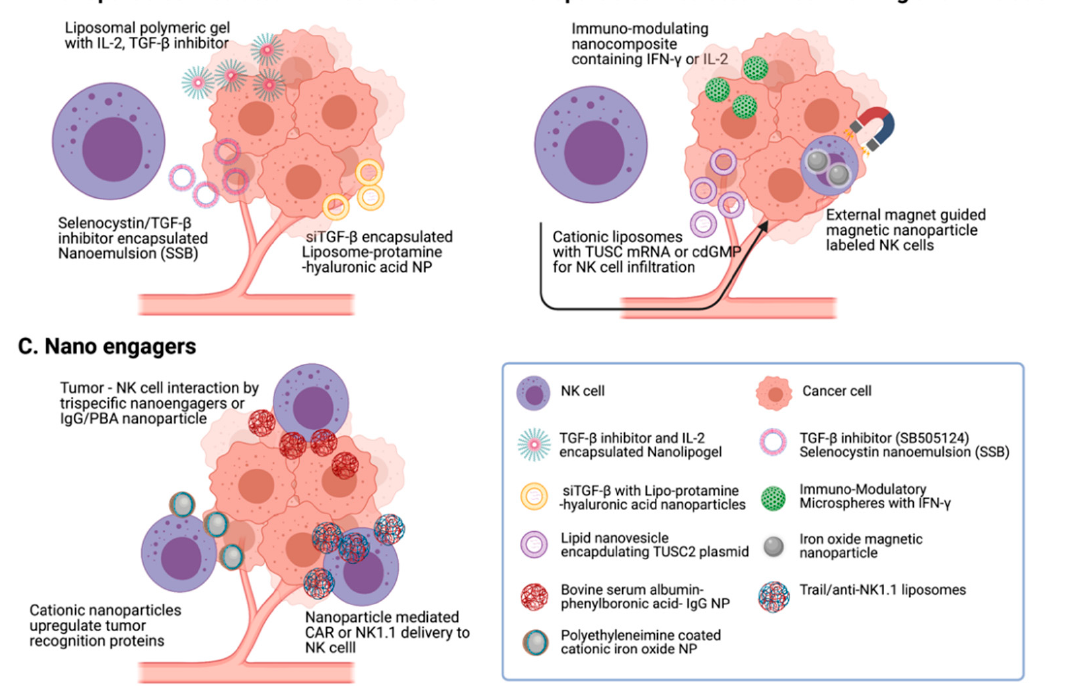
Figure 4. Nanomaterials for NK cell cancer-immunotherapy. Various nanoparticle-mediated strategies have been developed to augment NK cell therapeutic efficacy. ( A ) Liposome and nano-emulsion were used to modify tumor microenvironment with the inhibition of TGF- β signals. ( B ) Nanoparticles or liposomes encapsulating IFN- γ or tumor suppressor candidate (TUSC) improve NK cell homing. Magnetic nanoparticles labeled NK cells were guided into the tumor site, using external magnetic field applications. ( C ) Nanoengagers that enhance NK cells’ tumor recognition reinforced NK-cell-mediated tumor-cell-killing